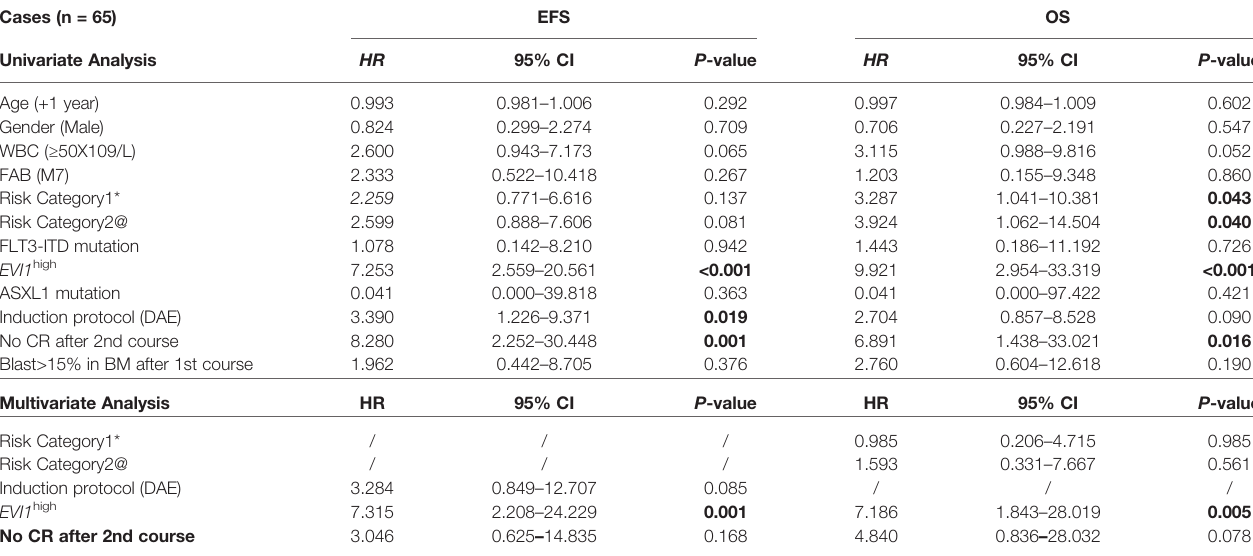
*Risk category based on treatment regimens. Refer to Supplementary Table S1 . @ Risk category based on cytogenetic strati fi cation of ELN 2017. Bold values indicated statistically signi fi cant